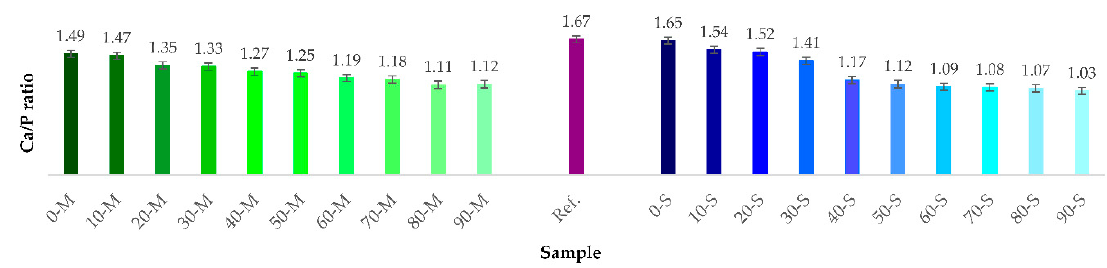
Figure 3. Ca/P molar ratio of the powders synthesized from both natural precursors (M—marble, S—seashell) with acid addition in the 0–90% range.